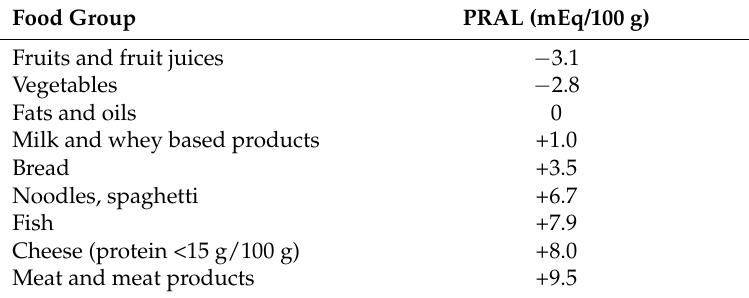
Table 1. Average potential renal acid loads (PRAL) of certain food groups (related to 100 g edible portion) [27].